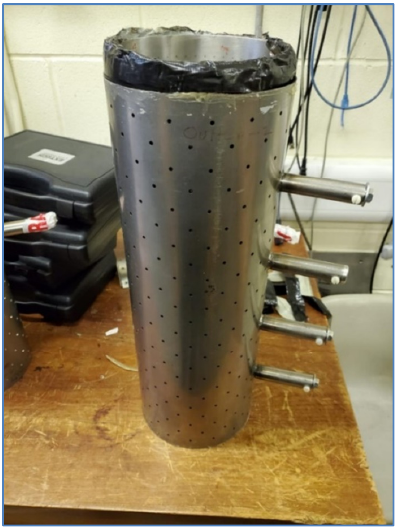
Fig. 2. Illustrates the layout of a double-layers perforated liner pattern utilized at this